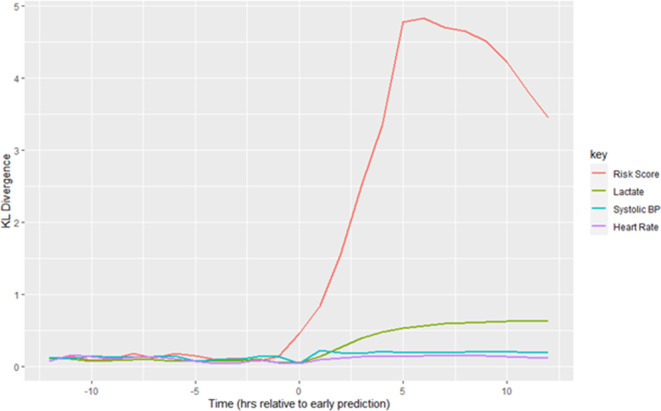
Kullback-Leibler Divergence of Risk Score and physiological variables between the highest-risk and lowest-risk clusters in the window surrounding time of early prediction in the MIMIC-III database.